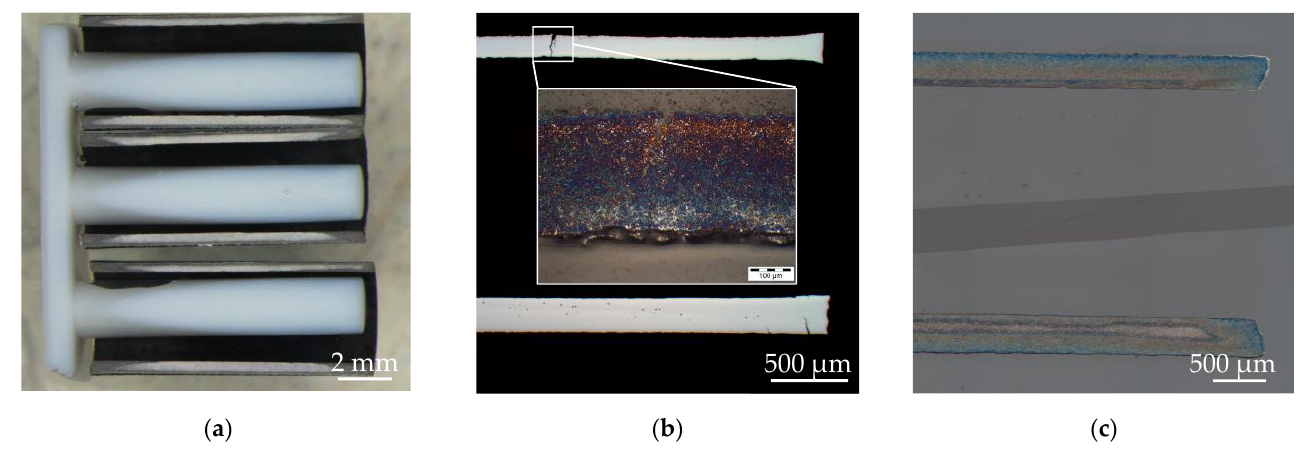
Figure 2. Sample preparation process: Iteration 1 ( a ): Macroscopic sample image showing inadequate nitriding; Iteration 2 ( b ): Stereo and light microscopic image showing cracks after nitriding process; Iteration 3 ( c ): light microscopic image showing a crack-free specimen with near continuous nitriding.